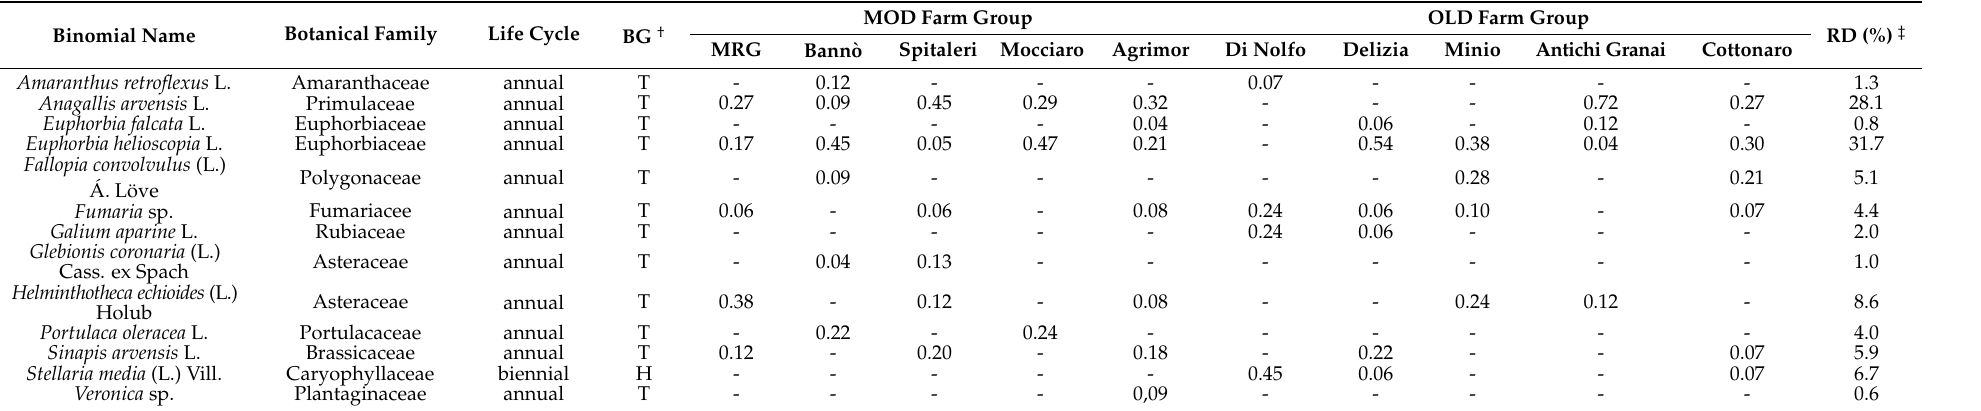
Table 1. Mean relative abundance values and mean relative densities (RD) of weed species in the total seedbank (0–15 cm) across the 10 farms under study. Weeds are grouped by botanical family, life cycle and biological group